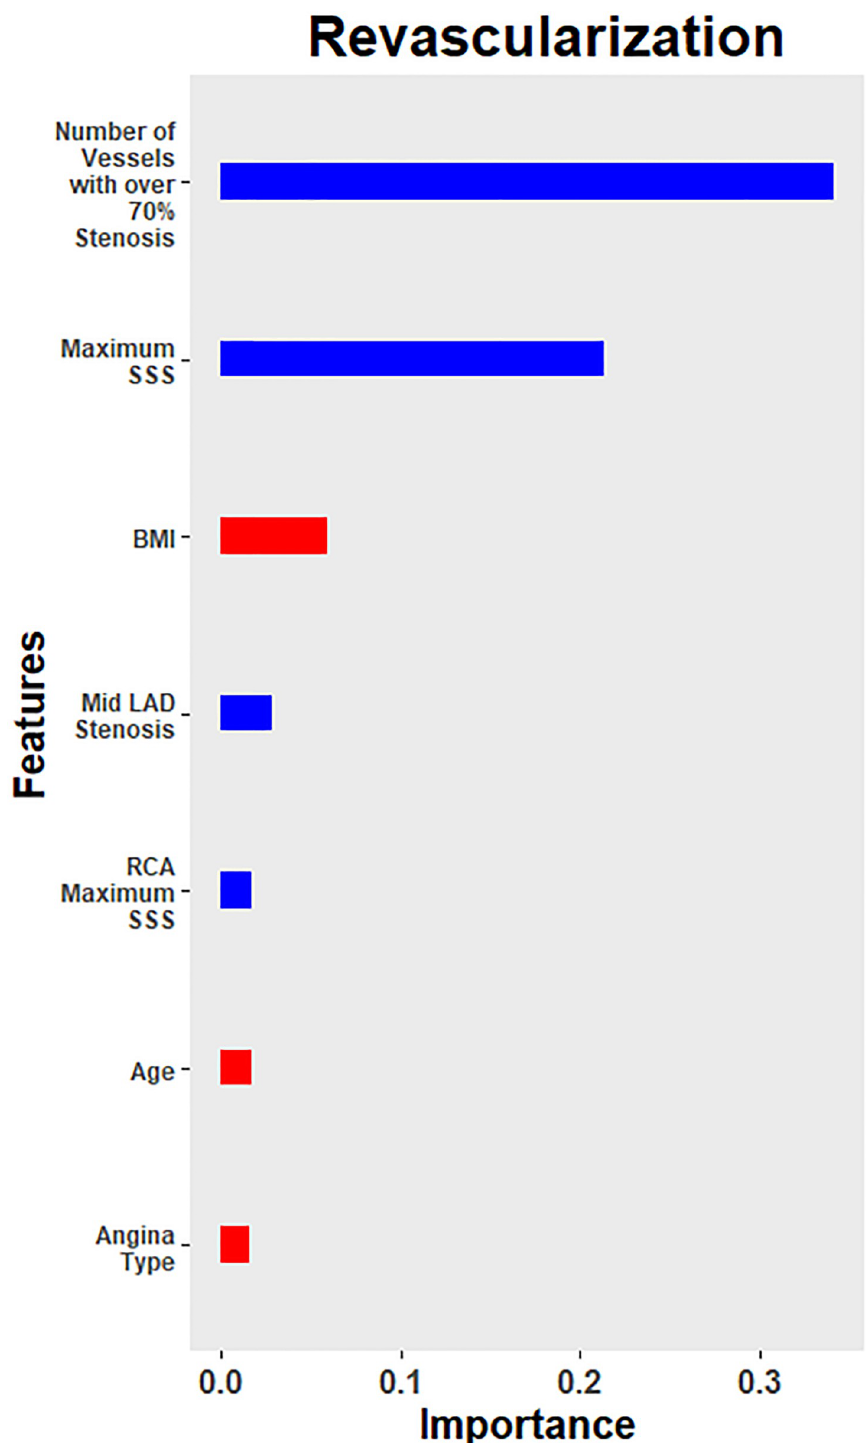
Fig 5. The relative importance of clinical (red) and image-based (blue) variables in the developed machine learning–based model for the prediction of 1-year revascularization. Abbreviations: BMI = body mass index, LAD = left anterior descending coronary artery, RCA = right coronary artery, SSS = maximum segment stenosis severity.